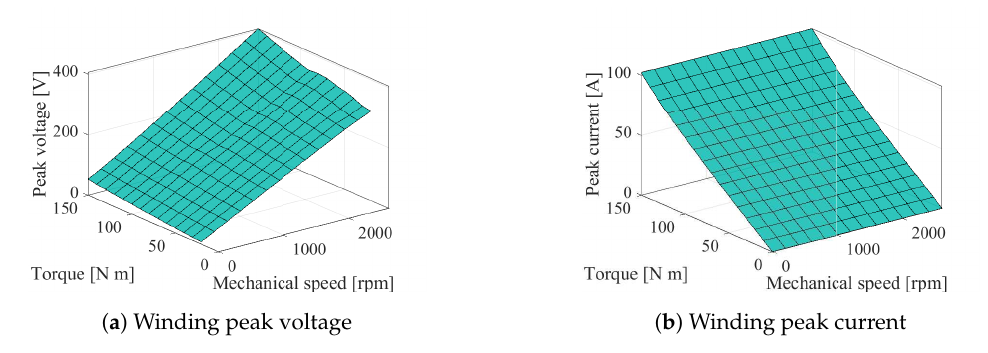
Figure 9. Electric motor voltage and current at different working points.